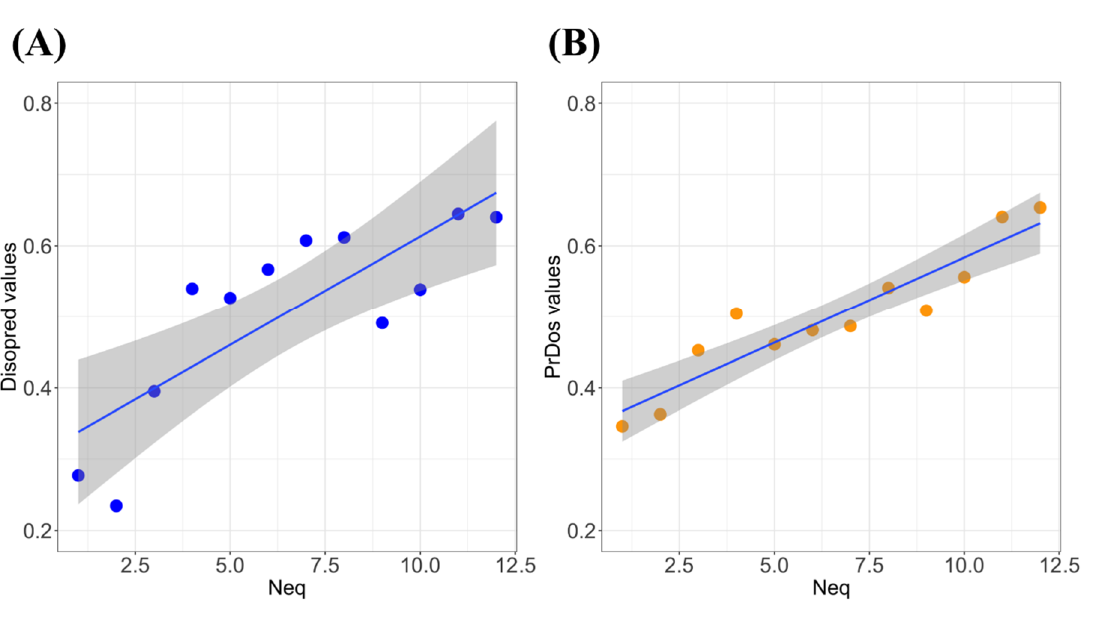
Figure 3. Analyses of N eq versus prediction disorder results on PED 3 dataset. ( A ) N eq values ( x -axis) vs. Figure 3 average Disopred3 values ( y -axis) (correlation is of 0.81) and ( B ) N eq values ( X -axis) vs. average PrDOS values ( y -axis) (correlation is of